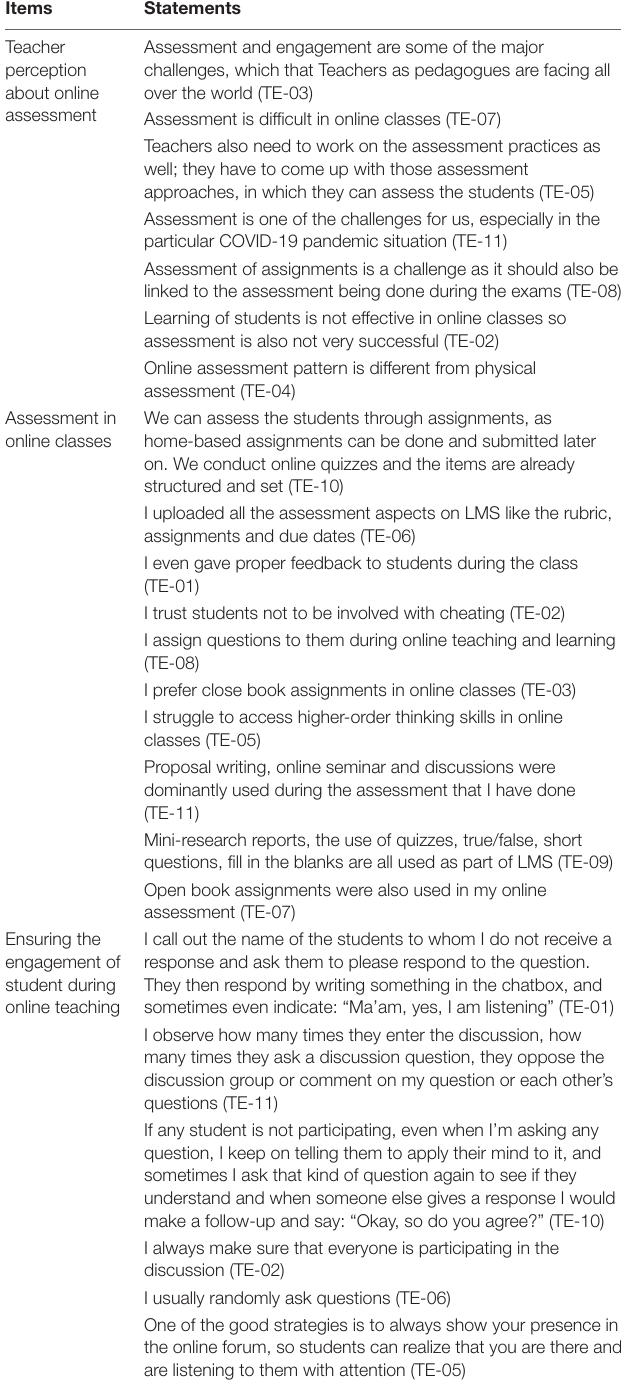
TABLE 6 | Students’ engagement and assessment in online classes during